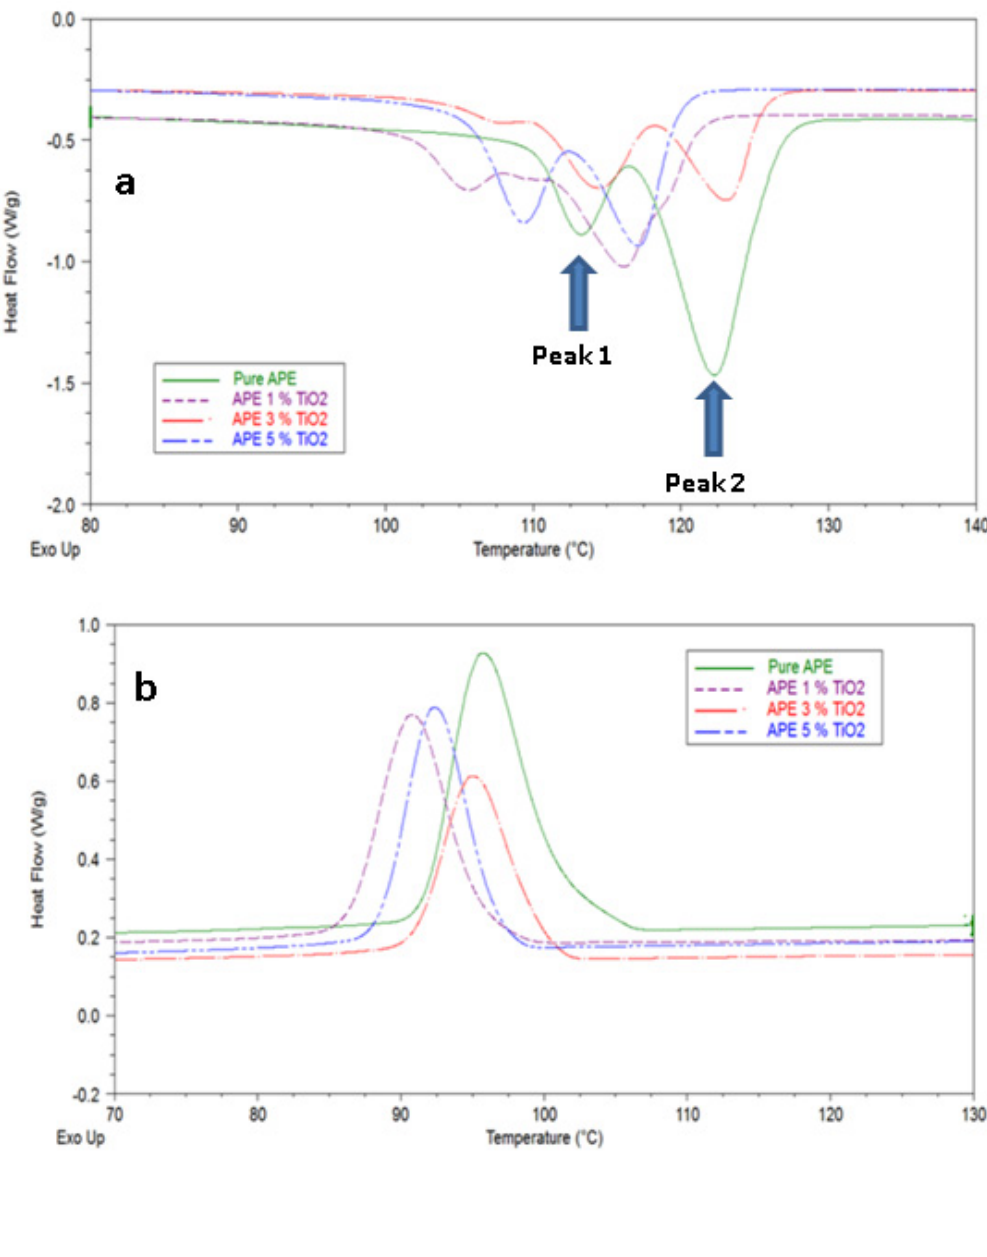
Fig. 3. DSC curves of pure APE and the APE/TiO